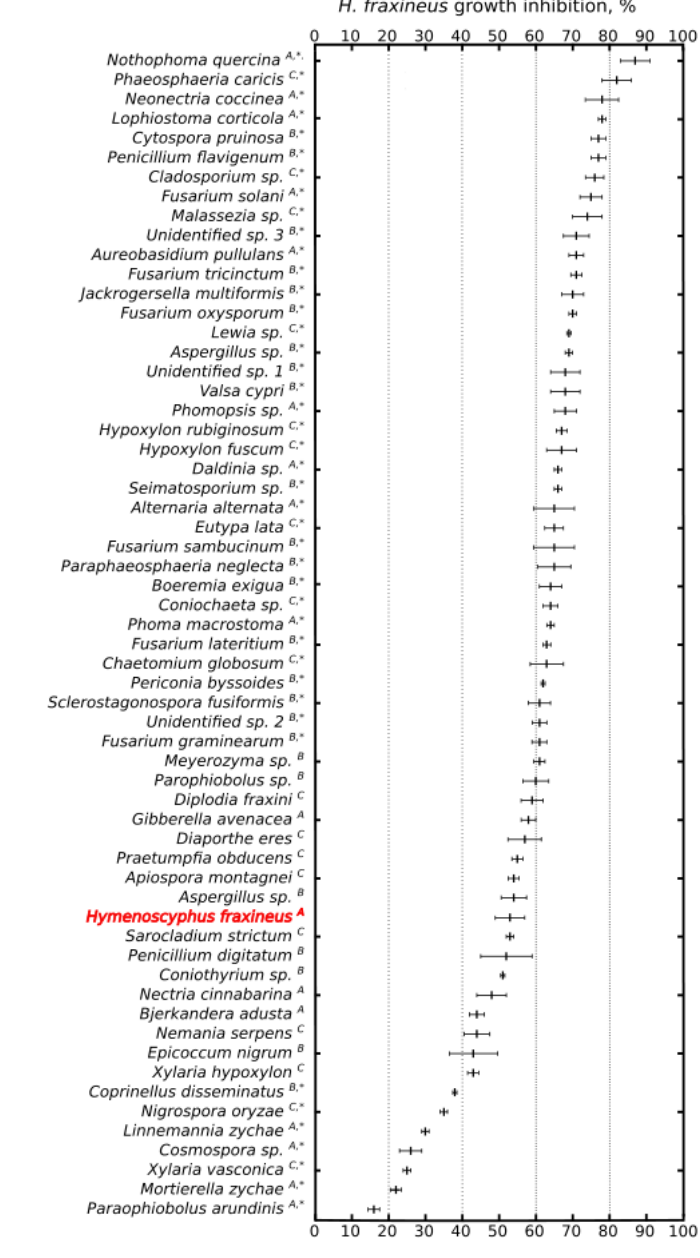
Figure 3. The effect of grown inhibition of Hymenoscyphus fraxineus by fungal taxa isolated from shoots and leaves of Fraxinus excelsior . Next to the species names, A denotes A type (deadlock) of mycelial interaction; B—B type (antibiosis); and C—C type (replacement). The symbol * denotes significantly higher or significantly lower growth inhibition of H. fraxineus compared to H. fraxineus self-inhibition (marked in red). The output of interaction is shown as the average value of inhibition factor ± SD. X-axis represents inhibition rate (%).